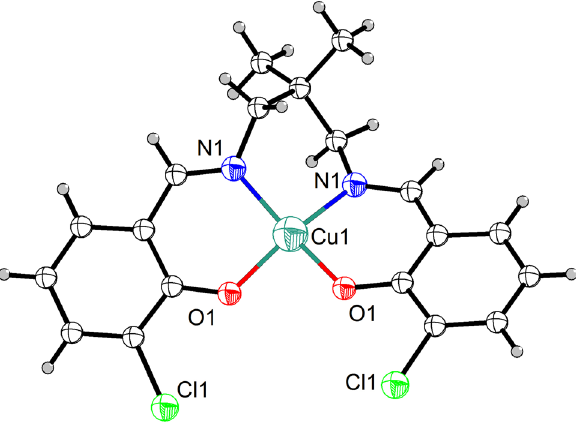
Table  : Data collection and handling.